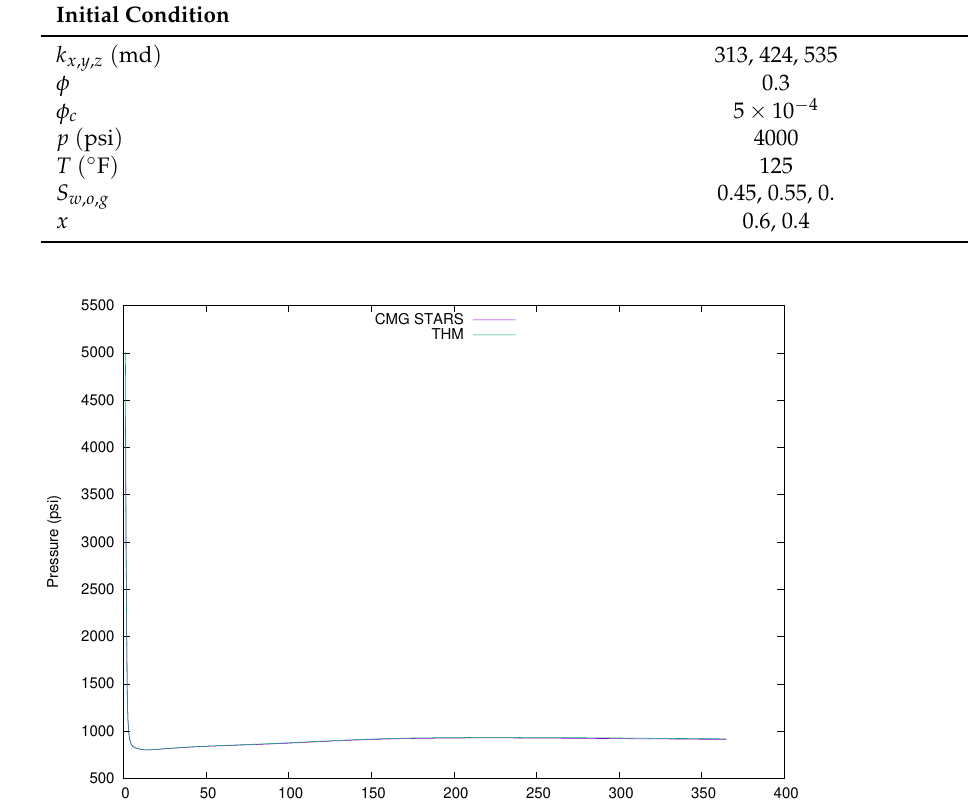
Table 5. Initial condition data for Example 1.